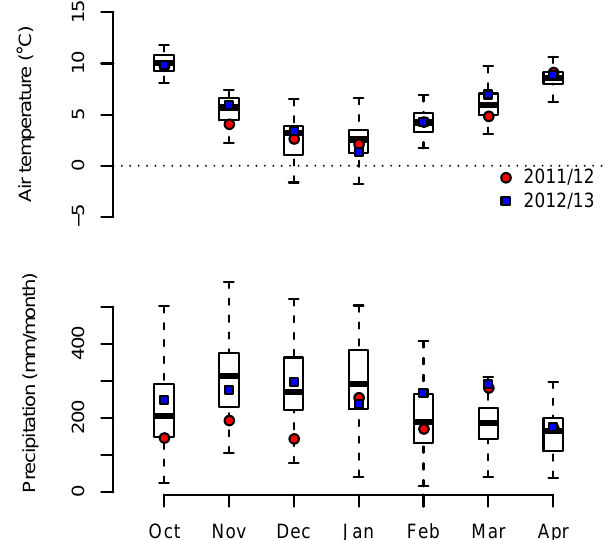
Fig. 2. Boxplots of monthly (October to April) mean air tempera- ture and monthly total precipitation recorded at the MKRF head- quarters station from 1962 to 2010. Red circles and blue squares represent conditions during the two winter periods (2011/2012 and 2012/2013, respectively) during which the detailed field study at Griffith Creek was